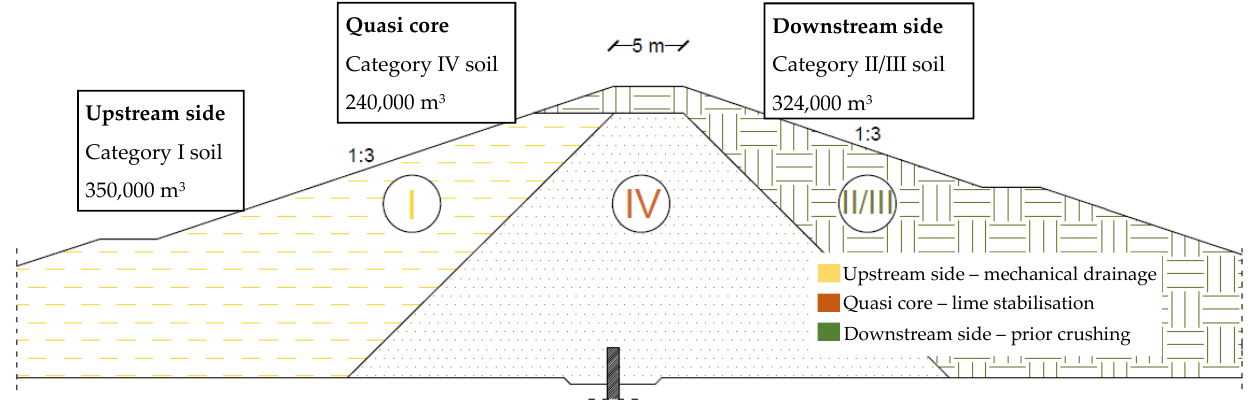
Figure 2. Characteristic cross-section of the dam body (internal analysis).